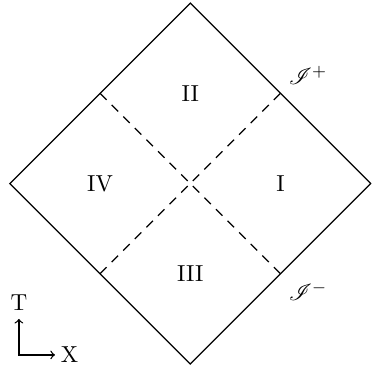
Figure 1 . Here, we depict the split of the spacetime into the four sectors in the compact coordinates T and X , which will be introduced below. Each coordinate patch u; (cid:26); ’ covers one such sector. The dashed lines denote the location of the Killing horizon. They intersect at the point T = X =